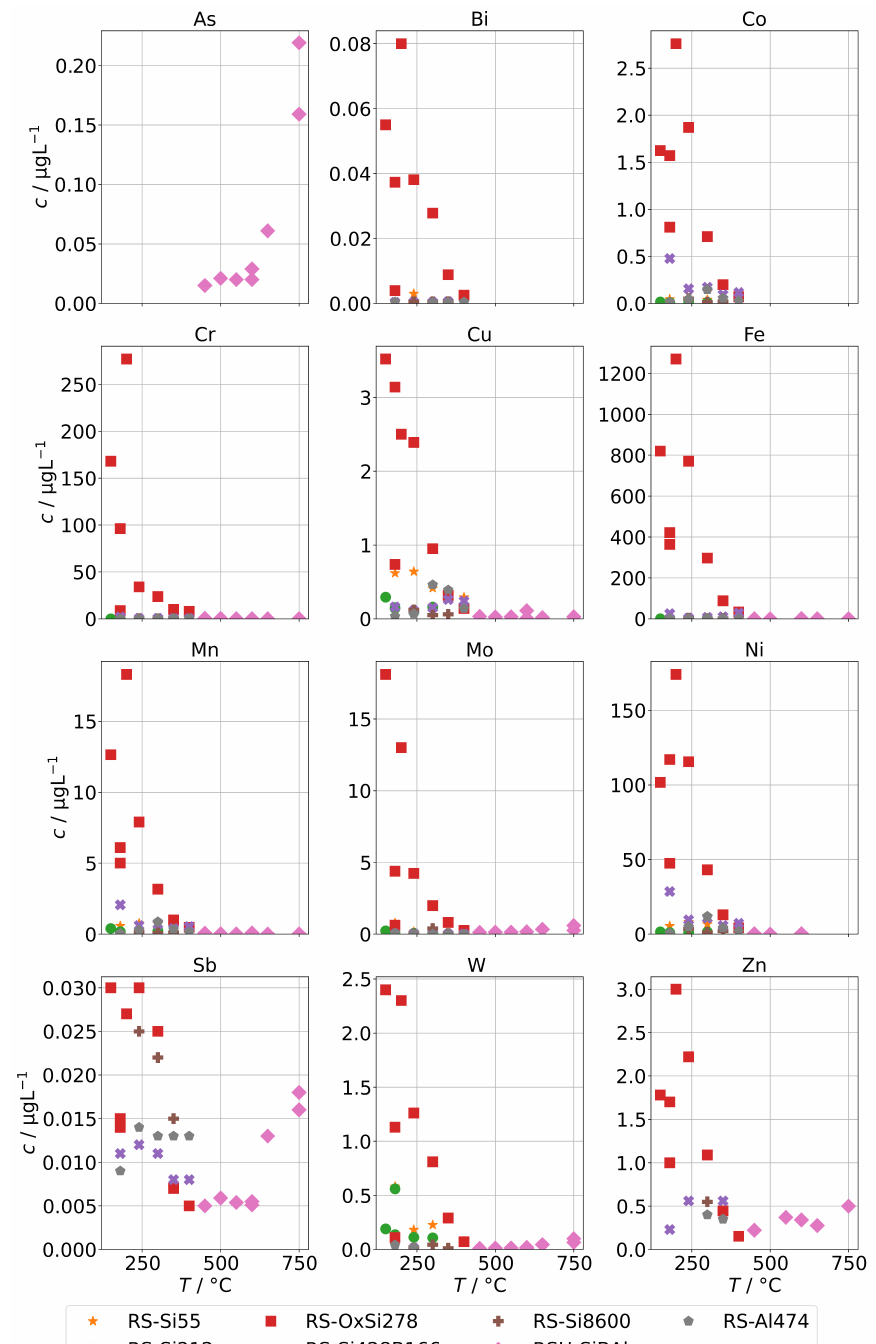
Figure 8. Concentrations of quantifiable species in condensates of the AG-SG obtained with spiked feed-water (group A) in dependence of operation